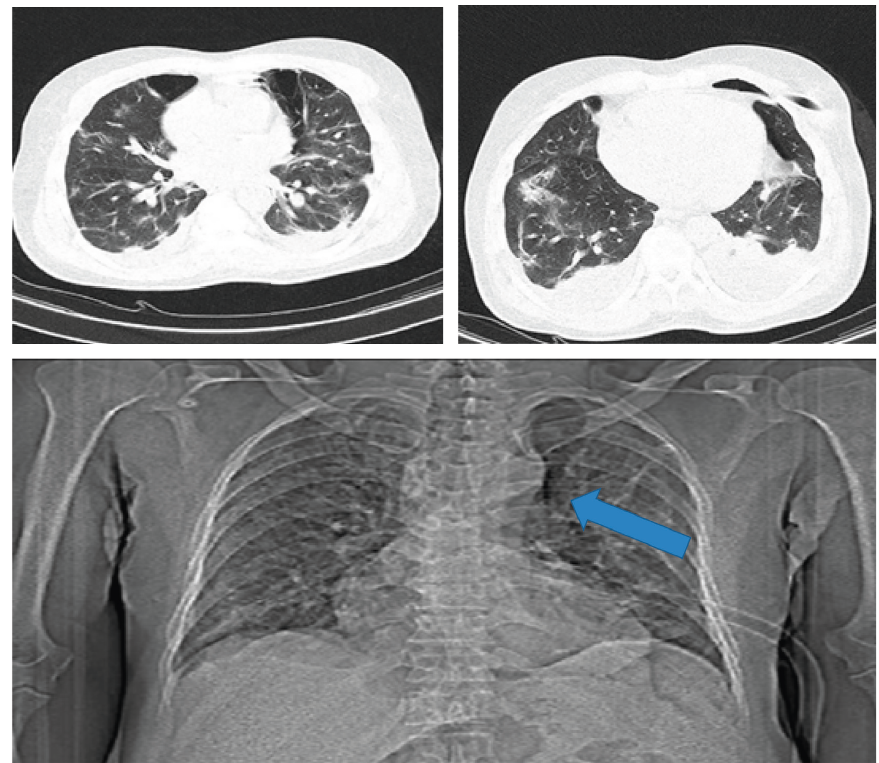
Figure 2: Chest CTshowing spontaneous pneumomediastinum (arrow), emphysema, bilateral pleural effusion, and ground-glass opacities of the lung, which decreased after